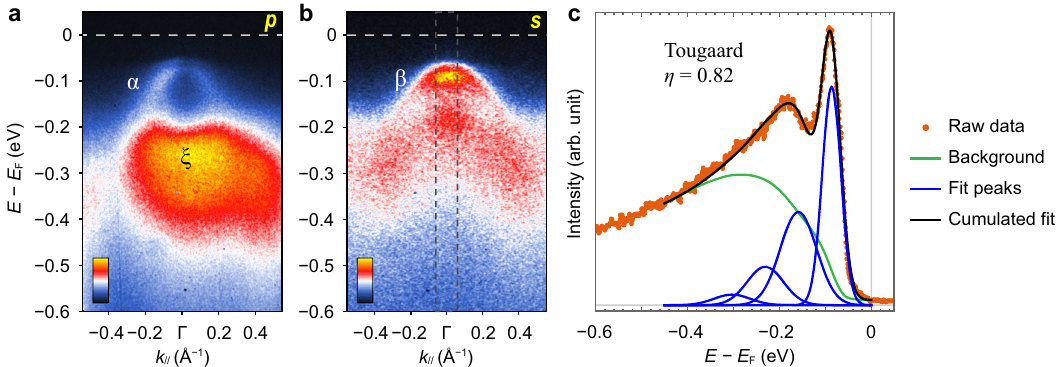
Fig. 3 Replica bands in monolayer FeSe/STO at the Γ point. a Photoemission intensity along cut #2 as indicated in Fig. 1a, measured with 24 eV photons in p polarization. b Photoemission intensity along cut #2 in Fig. 1a, measured with 50 eV photons in s polarization. c EDC at Γ , integrated over the momentum range indicated by the dashed rectangle in b . The data are fi t with the same method as in